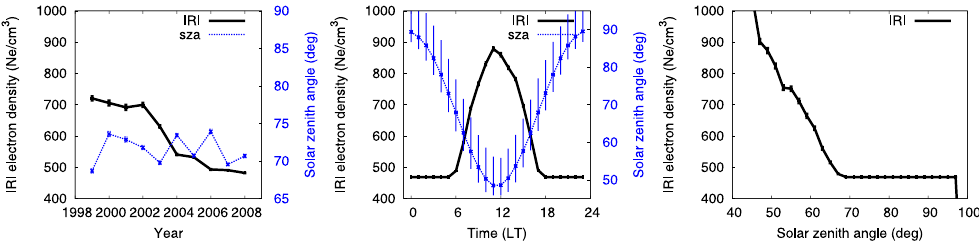
Fig. 8. Electron density (IRI, left axis) and solar zenith angle (right axis) for the time of measurements as a function of year, local time and solar zenith angle. With respect to local time, the seasonal variation of the solar zenith angle is indicated by the bars. Table 5. Correlation coefficients between PMSE/NLC occurrence rates per local time (12 values, top) and between solar zenith angle and IRI electron density per solar zenith angle (24 values, bottom). In brackets the 95%-confidence interval is given (after David, 1938). The correlation is significant (printed bold), if zero is not included in the confidence